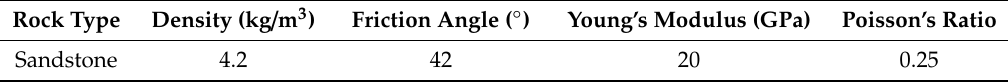
Table 1. Di ff erent input parameters used in FLAC 2D